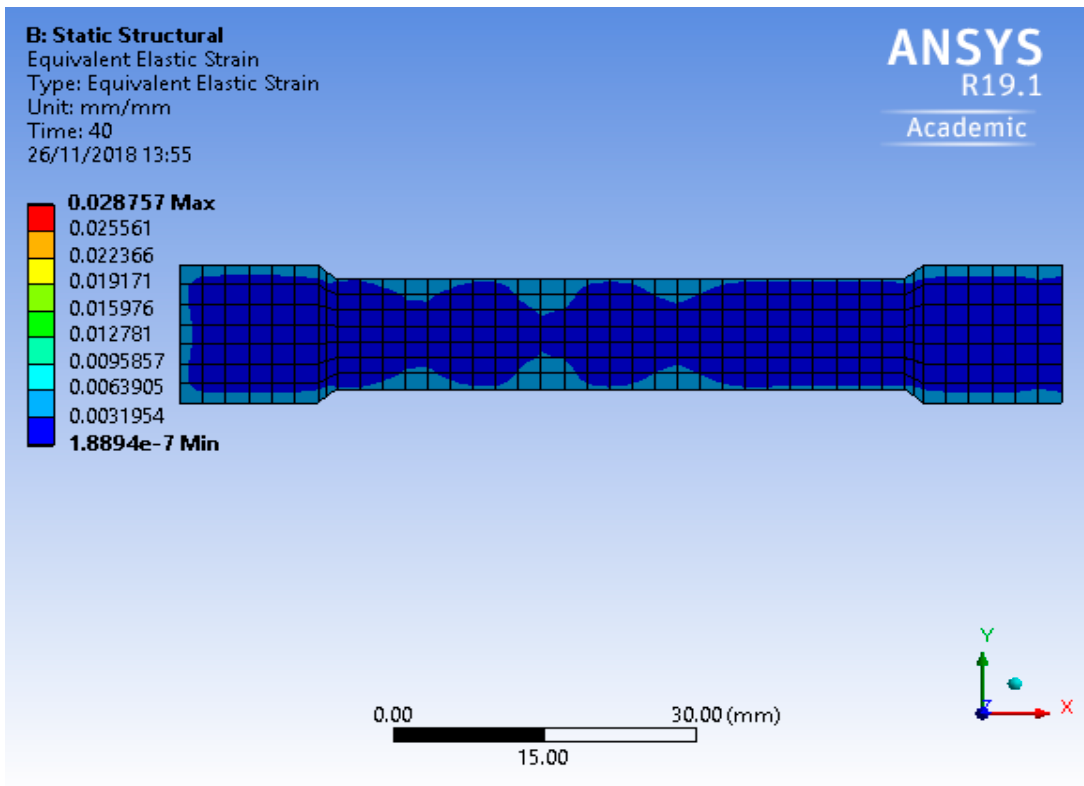
Figure 11. Thermal strain on the foil adjacent to the hot plate.